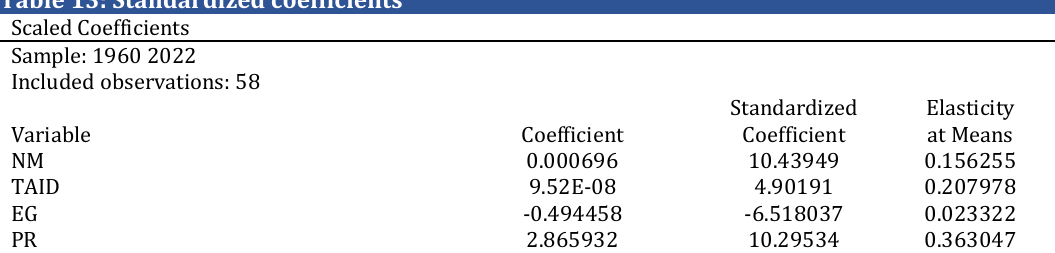
Table 13: Standardized coefficients Scaled Coefficients